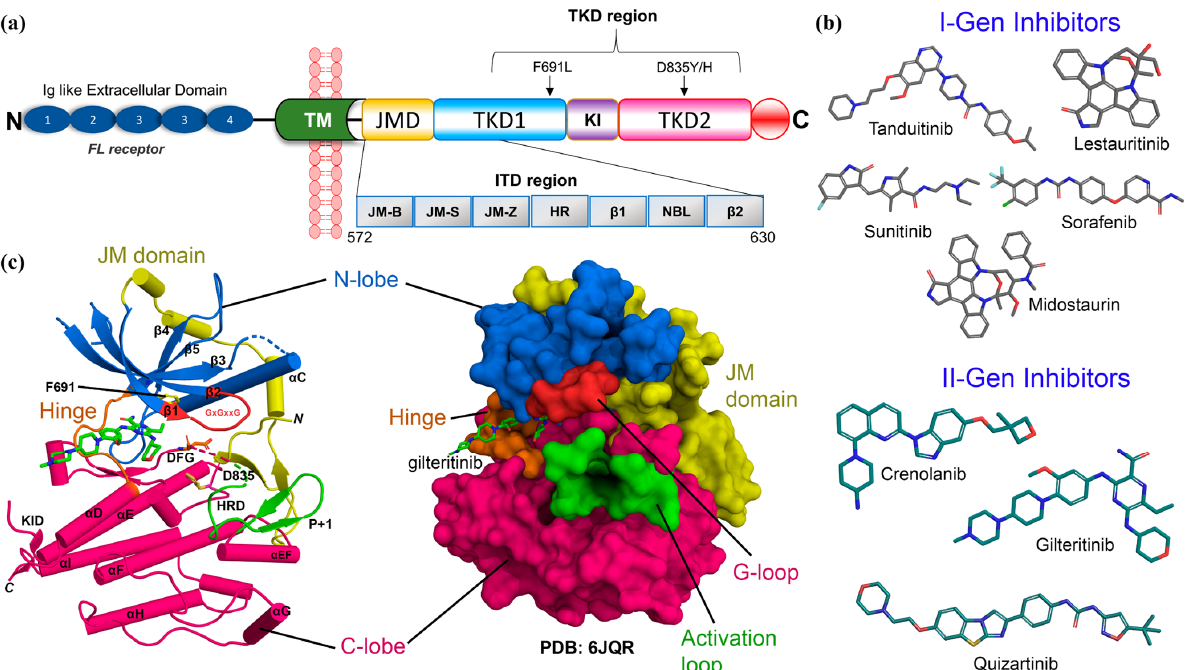
Figure 1. Domain map, inhibitors, and X-ray structure of FLT3. ( a ) Full-length FLT3 contains five immunoglobulins (Ig) like domains at the N-terminal, a transmembrane (TM) domain, and a juxtamembrane domain (JMD), followed by the tyrosine kinase domain (TKD) with a kinase insert (KI) and a C-terminal intracellular domain. F691L and D835Y/H are the two widely reported mutations in the TKD region, reported for 5% of the total AML cases. ( b ) FDA-approved first generation (I-Gen) and second generation (II-Gen) drugs as FLT3 inhibitors in grey and deep teal C atom color scheme. ( c ) X-ray structure of the gilteritinib-bound FLT3 (PDB: 6JQR). The various subregions of FLT3 are shown in cartoon and surface representation.